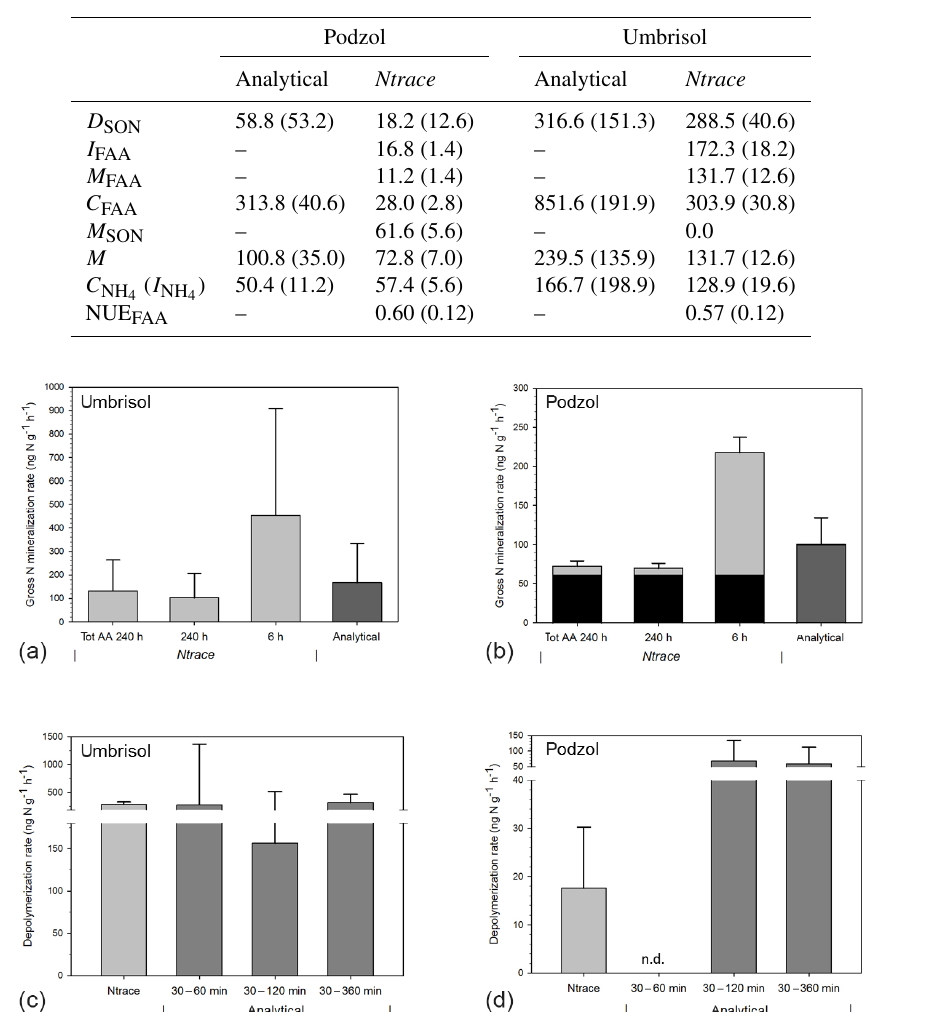
Table 2. N dynamics rates from analytical equations (Eqs. 1–4 and 6) and Ntrace numerical model; average in ngNg − 1 h − 1 and stan- dard deviation; NUE FAA is dimensionless. Peptide depolymerization rate ( D SON ); FAA immobilization rate ( I FAA ); FAA mineralization rate ( M FAA ); amino acid consumption ( C FAA ); mineralization rate of organic N ( M SON ); gross N mineralization ( M ); ammonium consump- tion ( C NH ); immobilization rate of NH + ( I NH ); and microbial amino acid nutrient use efficiency (NUE FAA ) (Eq. 5). For D SON , C FAA , 4 4 4 and NUE FAA , the time step 30 to 360min is presented; M FAA and I FAA for all 20 AAs over 240h. C FAA and M from Ntrace are calculated sums ( M = M SON + M FAA and C FAA = I FAA + M FAA ).